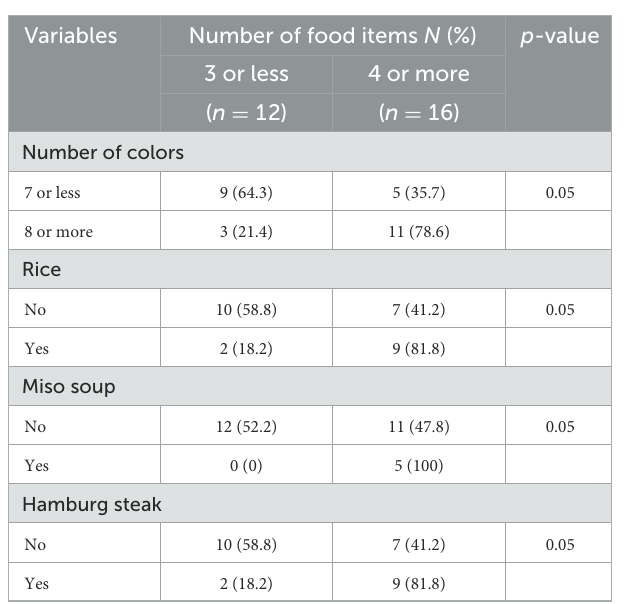
TABLE 2 Associations between the total number of food items in children’s drawings with the number of colors they use and specific foods that they draw.